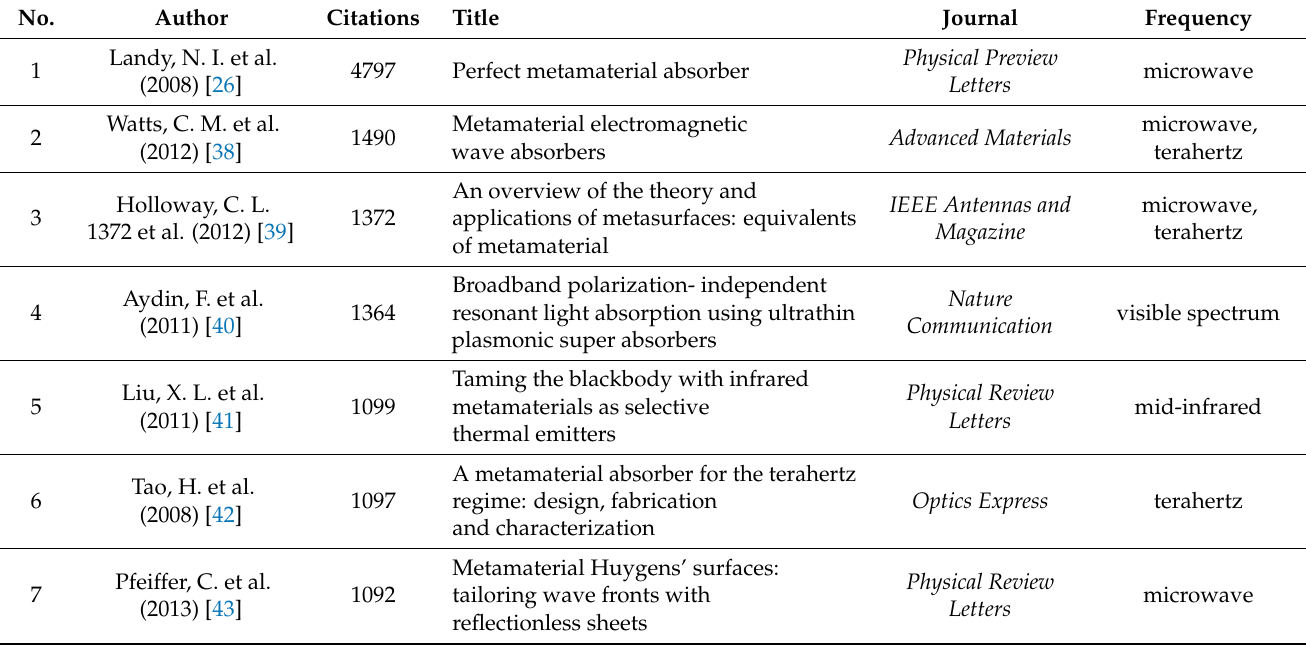
Table 6. Top ten co-cited publications in the research area of metamaterial absorbers.